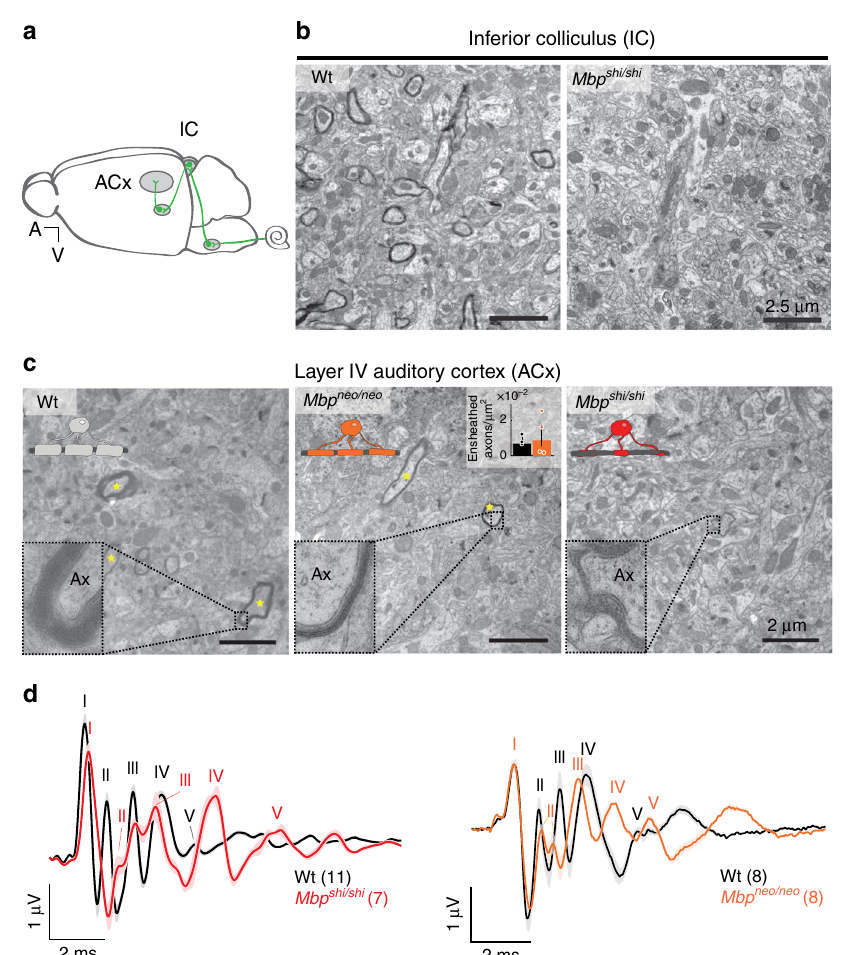
Fig. 1 Ensheathment pro fi les along the auditory system in normal and dysmyelinated models. a Scheme illustrating the auditory pathway with emphasis on the location of the inferior colliculus (IC) and auditory cortex (ACx). b Electron microscopy images of the IC of a Wt mouse (left panel) showing sparse compact myelin, and an Mbp shi/shi mouse (right panel), lacking electro-dense compact myelin. c Electron microscopy images of the auditory cortex of Wt (left), Mbp shi/shi (middle), and Mbp neo/neo mouse (right). Properly ensheathed axons in the ACx are marked with yellow asterisks. Insets show details of the myelin sheath of axons (Ax) from the respective image. Mbp shi/shi axons (right) show lack of compact myelin, while Mbp neo/neo axons (middle) show thinner compact myelin than Wt. The inset plot (middle) shows the quanti fi cation of the number of ensheathed axons per area in Wt (black, n = 3) and Mbp neo/neo (orange, n = 4), (two-sided Wilcoxon rank-sum test, P = 0.73, t = 0.434). The bar graph show the mean of all animals quanti fi ed (10 – 15 images per mouse). d Auditory brainstem-response (ABR) potentials. Left: group mean traces of control (black, n = 11). Pooled together seven Mbp + / + and four Mbp shi/ + , see Supplementary Fig. S2E for signi fi cances, and Mbp shi/shi (red, n = 7) mice. Each one of the fi ve peaks (I – V) can be attributed to activity at a different station along the auditory brainstem (see Supplementary Fig. S2Aii). Responses in Mbp shi/shi mice were delayed at all auditory stations. Wave II appears divided and merged with wave III. Right: group mean traces of control (black, n = 8) and Mbp neo/neo (orange, n = 8) mice. Responses in Mbp neo/neo mice were delayed at all auditory stations. Scale bars: 2.5 µ m ( b ), 2 µ m ( c ). Source data are provided as a Source Data fi compact but thinner myelin compared to Wt (Fig. 1c, middle between Wt and Mbp neo/neo mice (Supplementary Fig. S1G). panel). Dysmyelination of Mbp neo/neo was obvious by electron Fig. S1D). Interestingly, when quanti fi ed, Mbp neo/neo mice had the same number of ensheathed axons in the ACx as their respective controls (Fig. 1c, middle-panel graph).